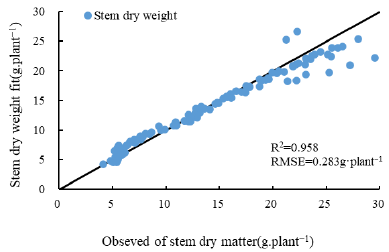
exactly. Comparing the simulated values with the line provides a better view of the simulation.